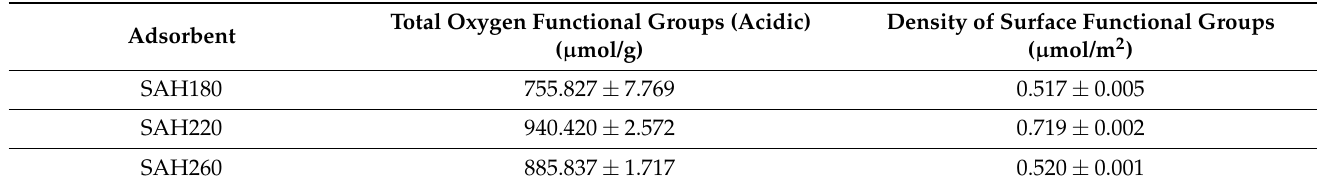
Table 2. Total and density of oxygen functional groups (acidic) of superactivated hydrochars (SAH180, SAH220 and